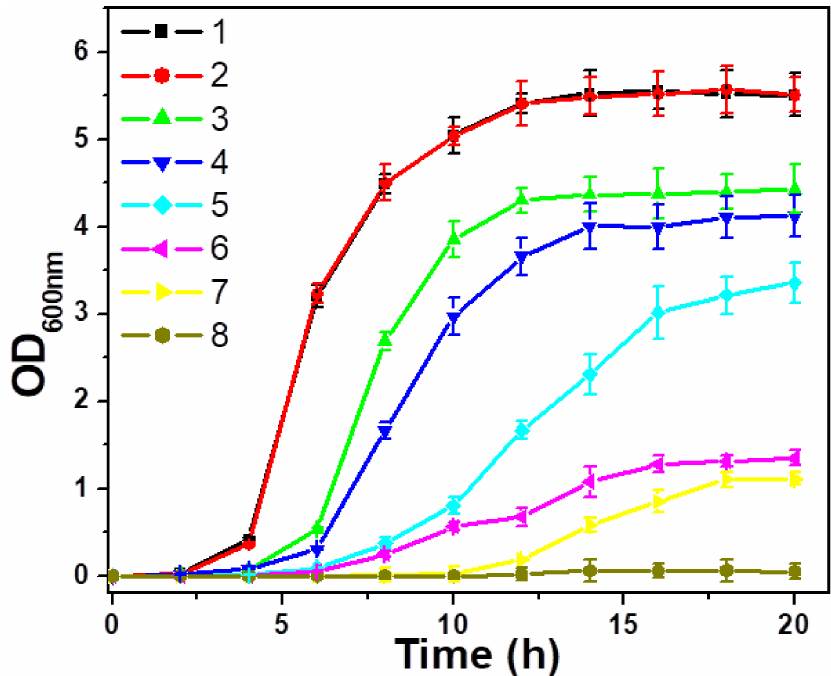
Figure 5. Growth curves of S. aureus species subjected to different treatments: ( 1 ) blank (control); ( 2 ) NIR; ( 3 ) ZO; ( 4 ) ZO + NIR; ( 5 ) ZB; ( 6 ) ZB + NIR; ( 7 ) AZB; and ( 8 ) AZB + NIR. The concentration of each nanomaterial (ZO, ZB, and AZB) was 25 µ g mL − 1 (the data are shown as the mean of